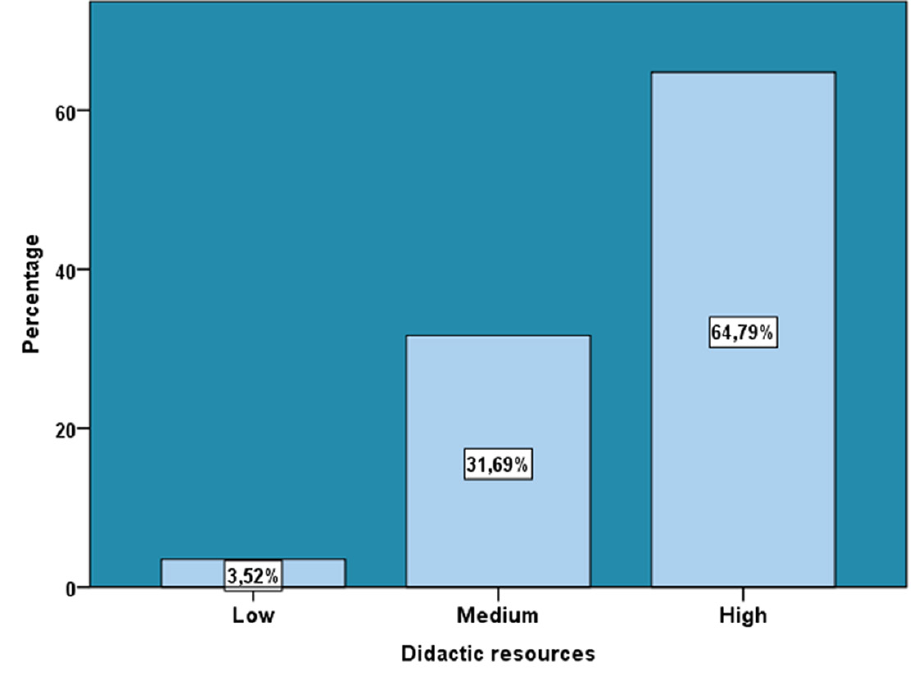
Fig. 5. Analysis of dimension 2: Teaching